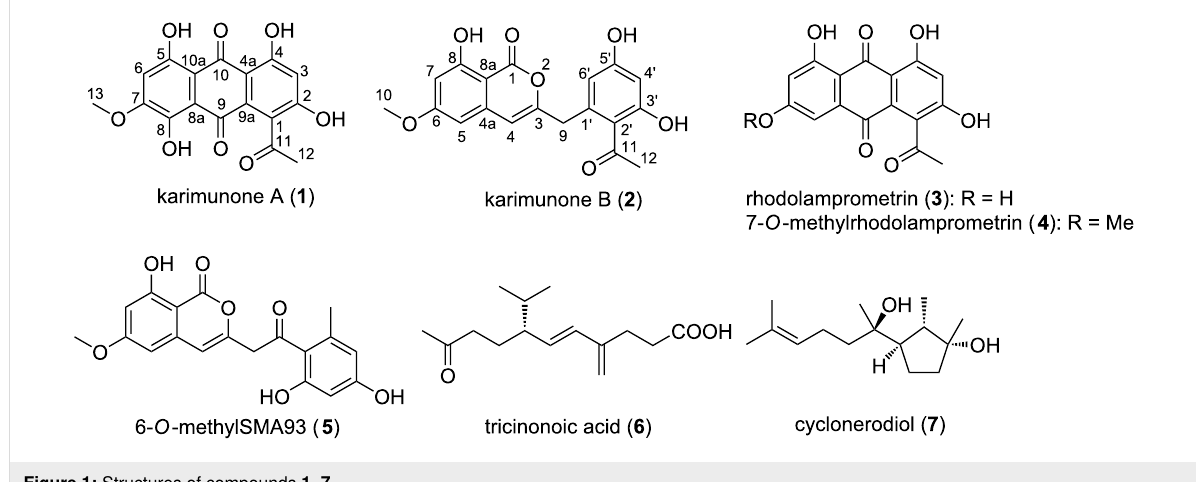
Figure 1: Structures of compounds 1 – 7